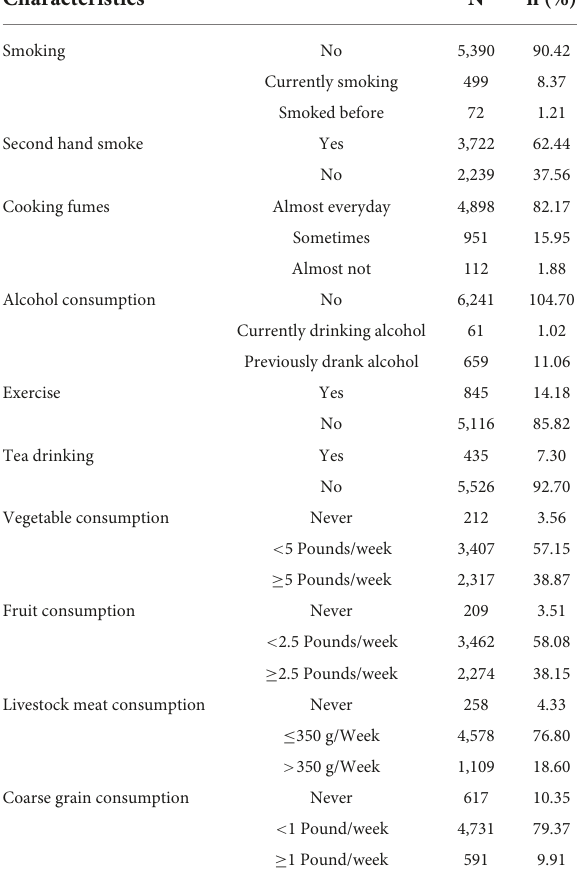
TABLE 3 Living conditions of the cervical cancer screening population. Characteristics